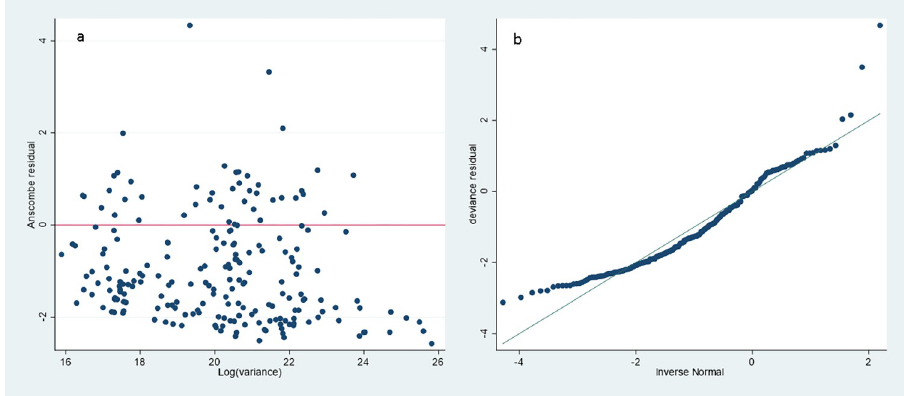
Fig 3. Anscombe (section a) and deviance (section b) residuals to assess the model